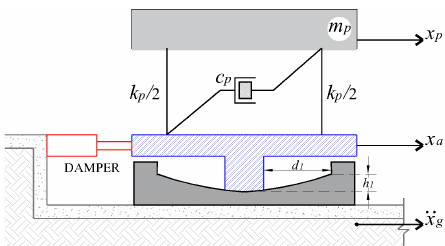
Figure 3. Schematic model of an isolated-structure with a friction pendulum system (FPS) and a damper.